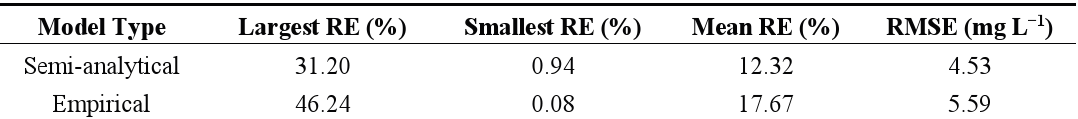
Table 4. The comparison of the performance between semi-analytical model and empirical model using the testing dataset of 20 validation points.